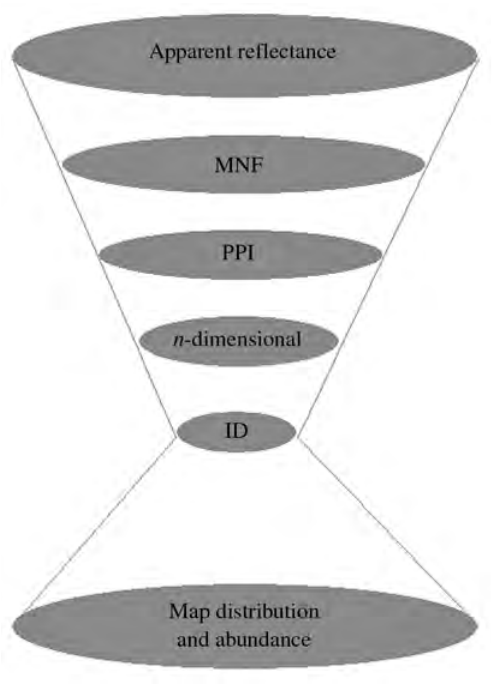
Fig. 2. AIG «hourglass» hyperspectral data pro- cessing scheme. Large HSI datasets are reduced to a few key spectra (at the neck of the hourglass) that ex- plain the data using spatial and spectral data reduc- tion techniques (Boardman et al ., 1995). Pixel-based spectral mapping methods are then applied to the full HSI